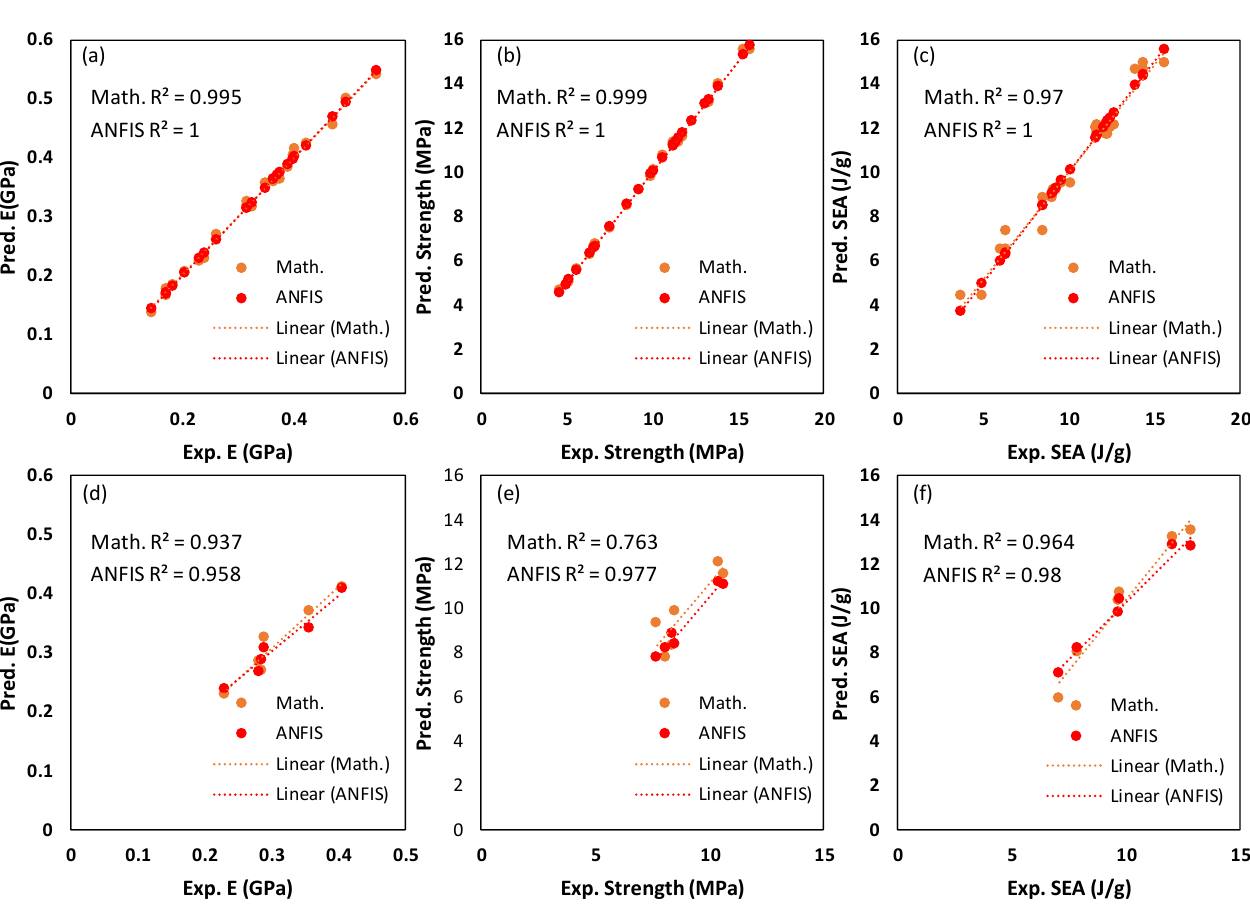
Figure 17. Experimental results vs. mathematical and ANFIS predicted results for the training and testing data sets: ( a ) training data of E, ( b ) training data of σ peak , ( c ) training data of SEA, ( d ) testing data of E, ( e ) testing data of σ peak , and ( f ) testing data of SEA. Table 12. Experimental and predicted results of the testing data Table 11. MAPE of the mathematical and ANFIS prediction models based on the testing data set.